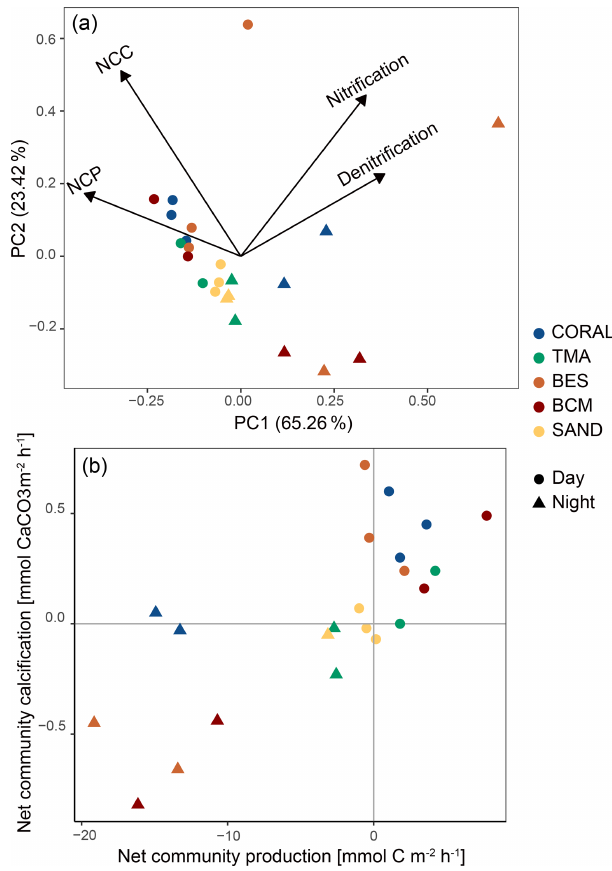
Figure 7. (a) Principal component analysis (PCA) diagram display- ing the spatial variation of all incubations along the first two princi- pal components. Processes are plotted as vectors, and dots represent daytime incubations, while triangles depict night-time incubations. Colour refers to the type of substrate incubated. (b) NCP vs. NCC rates for every incubation. Each dot/triangle represents an individ- ual incubation, and colour indicates community